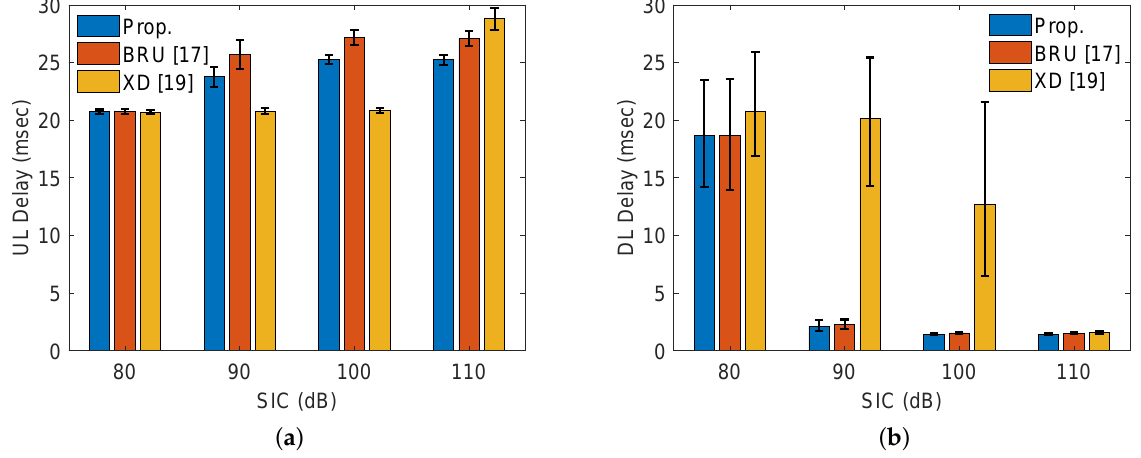
Figure 7. Delay based on SIC ( N = 40) for ( a ) UL and ( b )